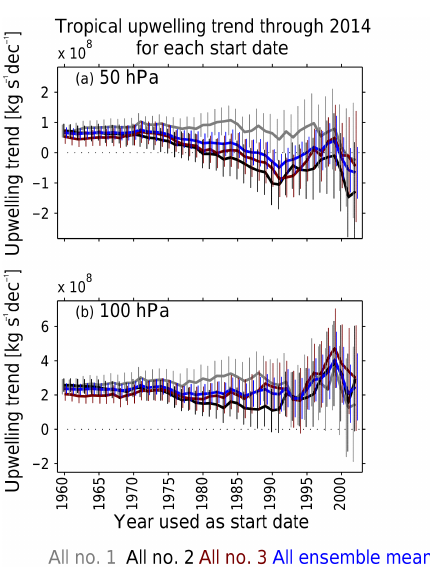
Figure 4. As in Fig. 3 but for the upwelling mass flux in the tropics.